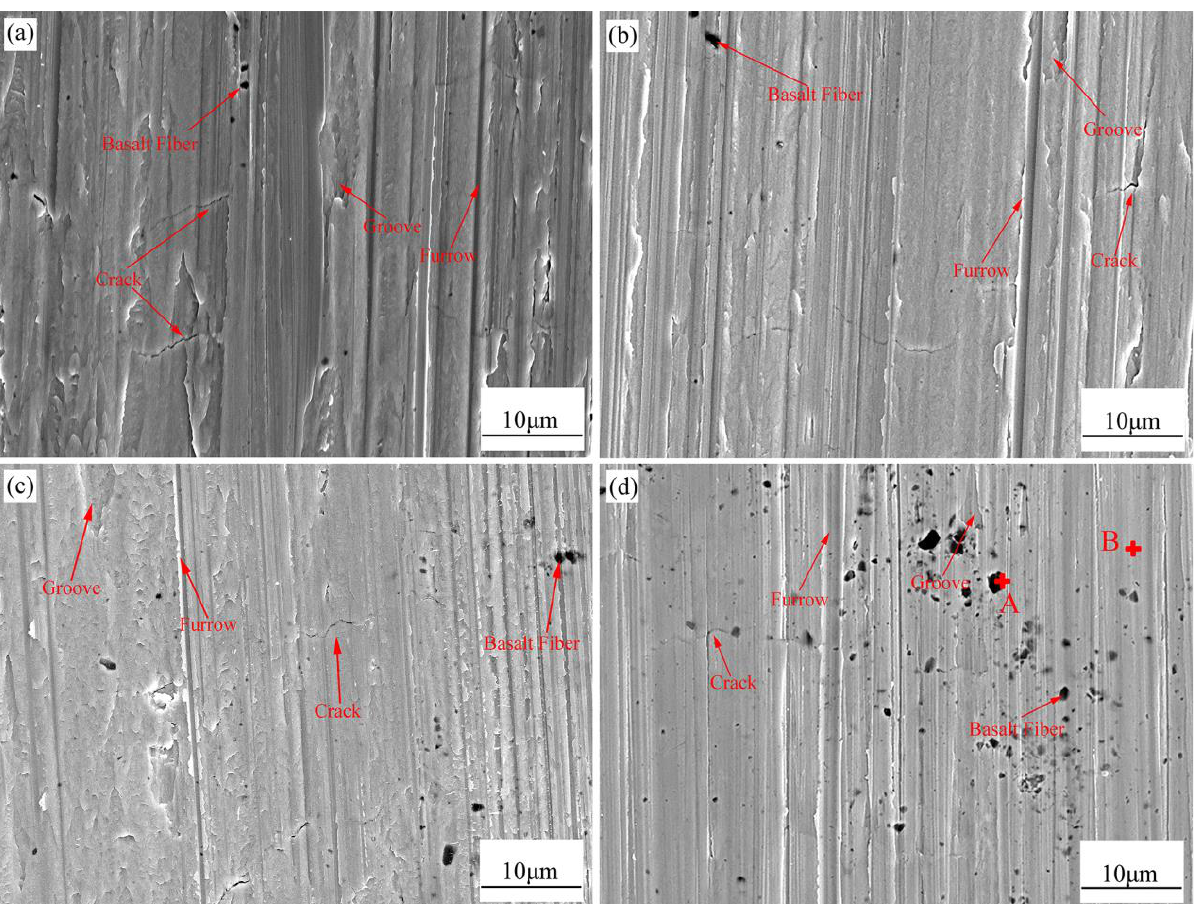
Figure 10. SEM image of wear surface of composites with different basalt fiber contents: ( a ) 0.5 wt.%, ( b ) 1 wt.%, ( c ) 1.5 wt.%, ( d ) 2 wt.%.